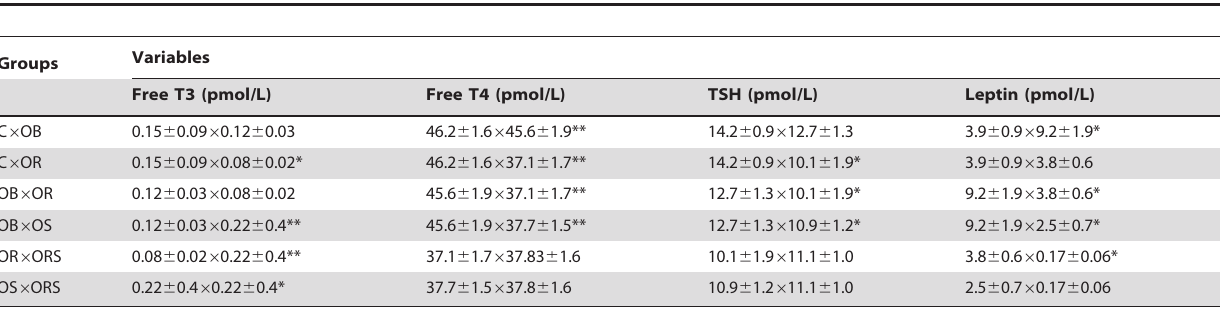
Table 5. Free triiodothyronine; free tyroxine (free T4); Thyroid Stimulating Hormone (TSH); and leptin serum concentrations.